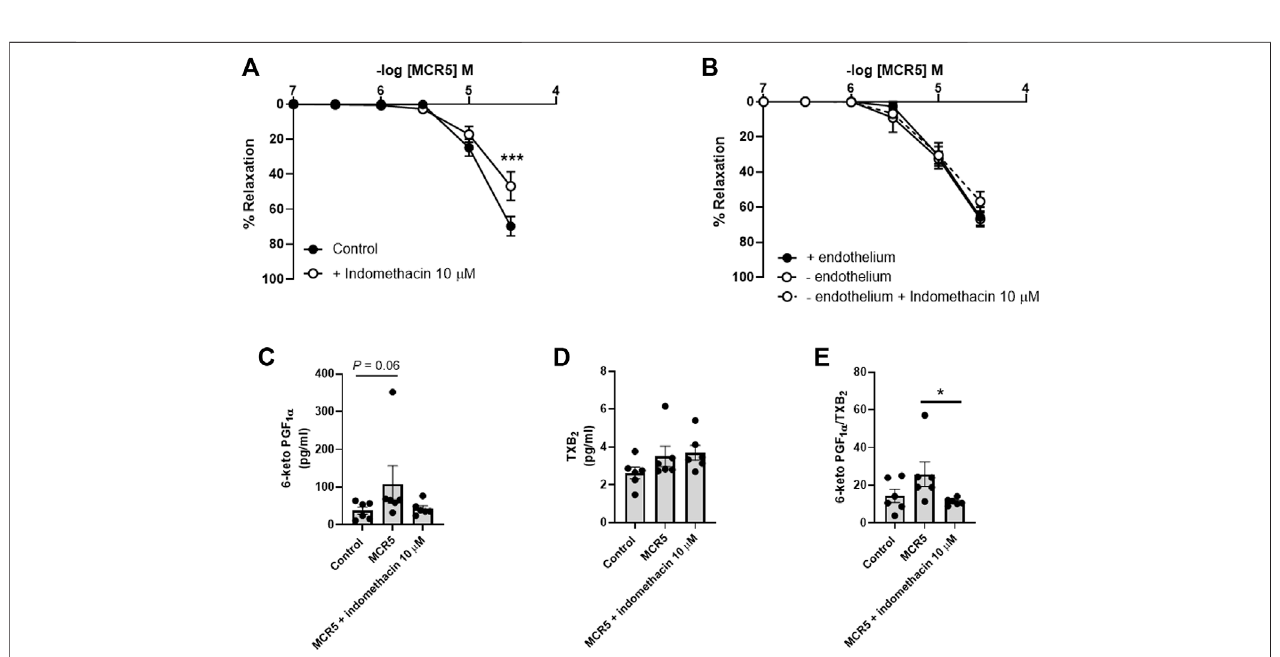
FIGURE 7 | Effects of COX inhibition on MCR5-induced aortic relaxations and prostanoids production. Concentration-response curves to MCR5 in U46619-pre- contracted aortic rings from young OF1 mice in the absence (control) or presence of the COX inhibitor indomethacin (10 µM) (A) . Concentration-response curves to MCR5inendotheliumdenudedarteries(-endothelium)intheabsenceorpresenceofindomethacin (B) .LevelsofPGI 2 andTXB 2 metabolites,6-ketoPGF 1 α (C) andTXB 2 (D) , respectively, and the 6-ketoPGF 1 α /TXB 2 ratio (E) , in the Krebs-Henseleit solution collected after concentration-response curves to MCR5 in U46619-pre- contracted aortic rings from young OF1 mice. Results are mean ± SEM from n = 7 (A) , 4 – 6 (B) , and 6 (C , D , and (E) . ppp p < 0.001 by two-way repeated measures ANOVA with Bonferroni ’ s post hoc test (A) ; p p < 0.05 by Kruskal-Wallis with Dunn ’ s post hoc test (C,E) .